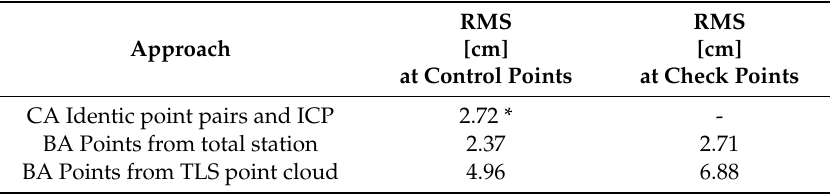
Table 3. RMS on control and check points for the bulwark exterior